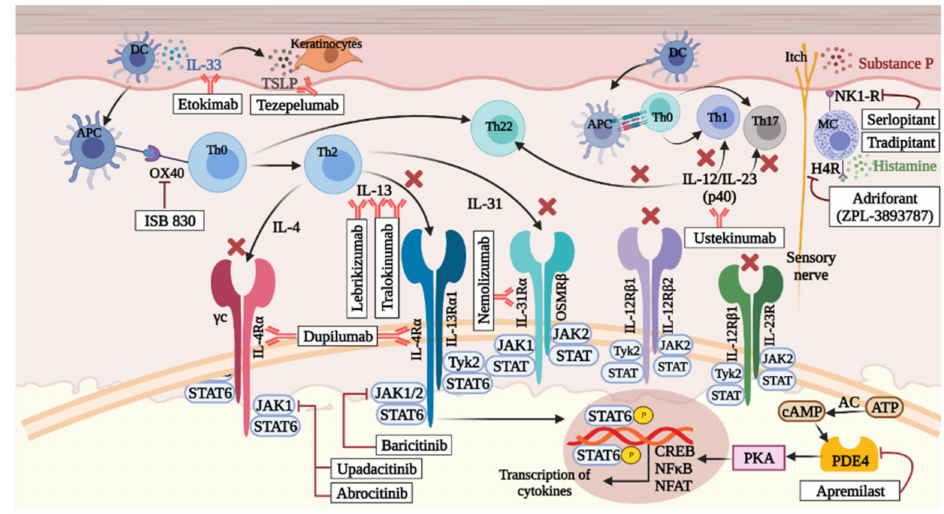
Figure 2. A summary of various therapeutic biologics and small molecules used to treat